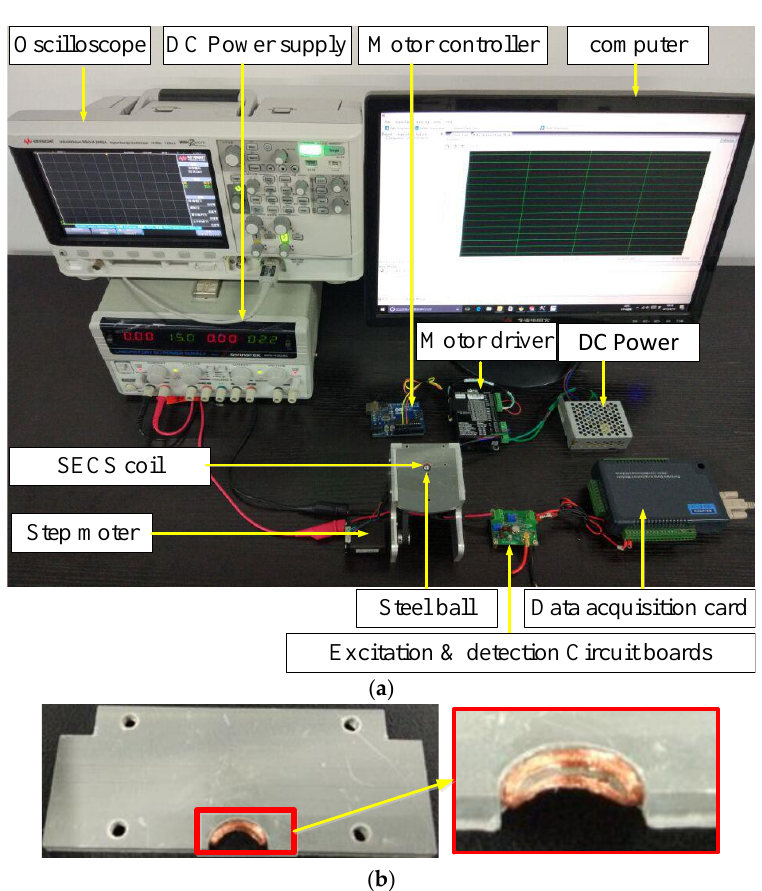
Figure 7. A test of the steel ball surface quality detection system. ( a ) SECS experimental testing system and ( b ) SECS coil projected and built in house.